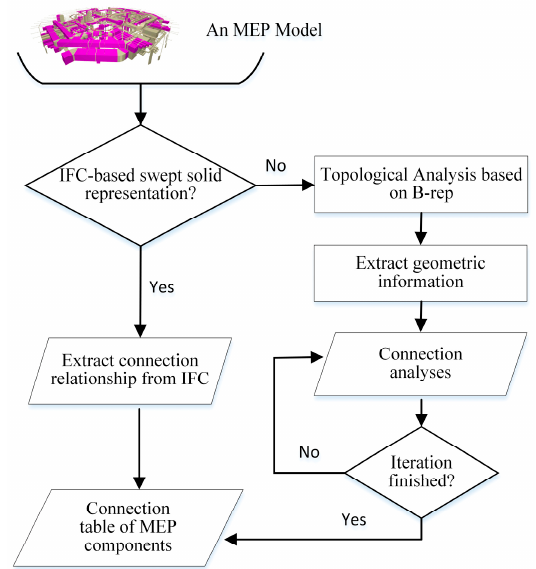
Figure 4. BIM-based topological analysis within MEP systems.